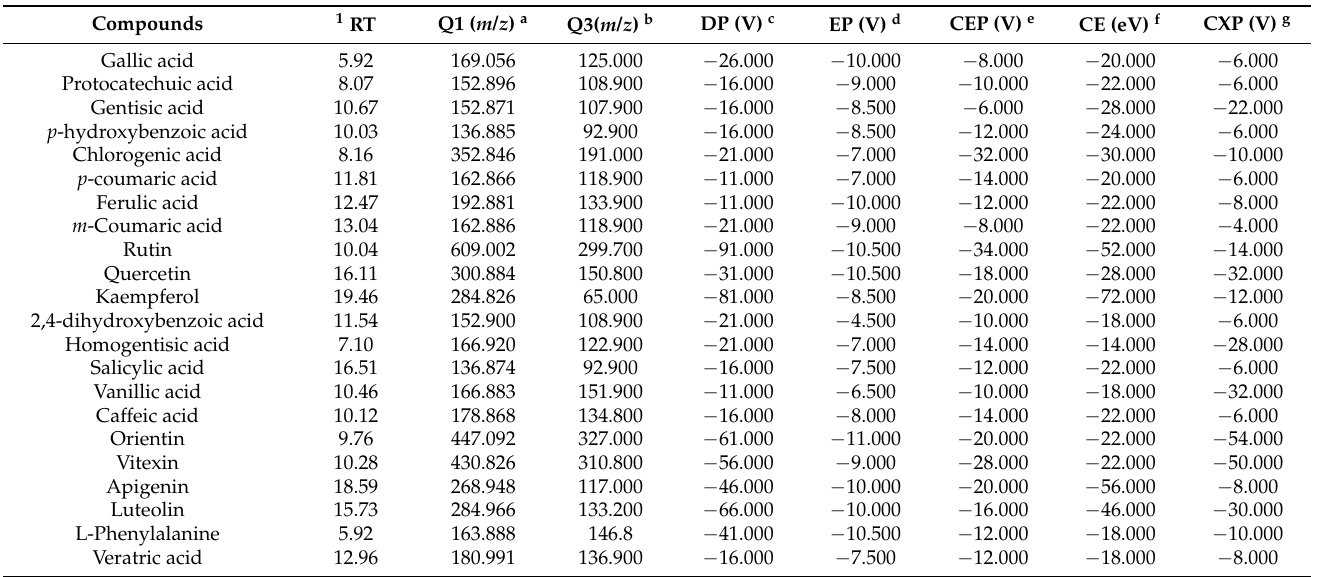
were significantly higher in the Russian accessions. Our findings indicate that the bio- chemical properties of MS accessions can be used to further improve the MS hybridization program and aid in obtaining new varieties with desirable levels of phenolic compounds. Table 6. LC-MS/MS parameters for quantitative analysis of 22 phenolic compounds.